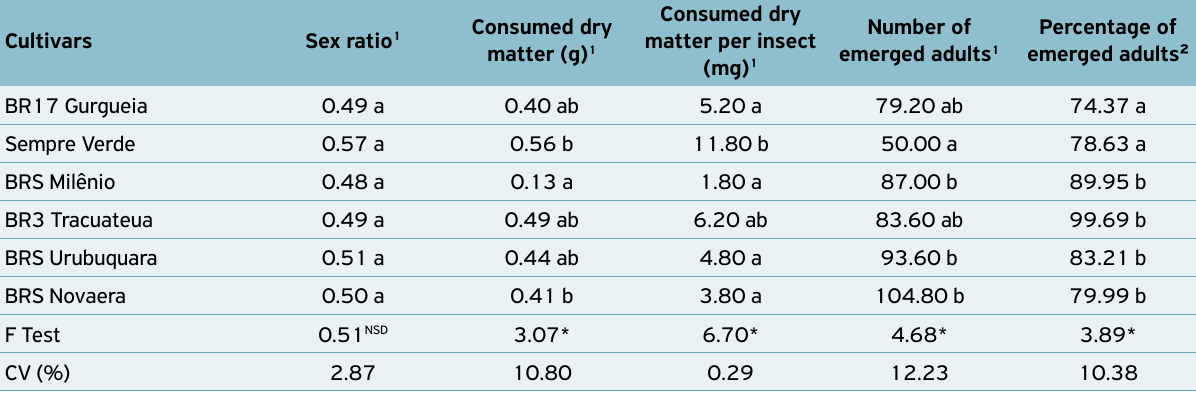
Table 2. Sex ratio, consumed dry matter, consumed dry matter per insect, number of emerged adults and percentage of Bruchidius atrolineatus